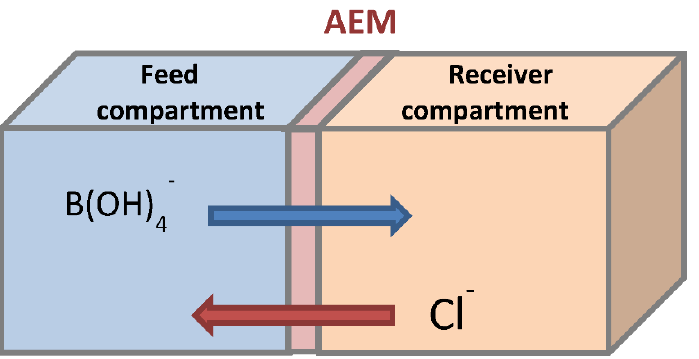
Figure 1. Schematic flow diagram of a Donnan dialysis system for boron removal (in an alkaline environment).